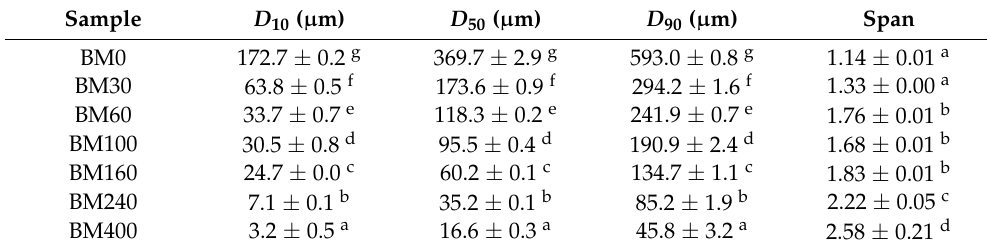
Table 1. Particle size and spans of PIDF samples at different scales.